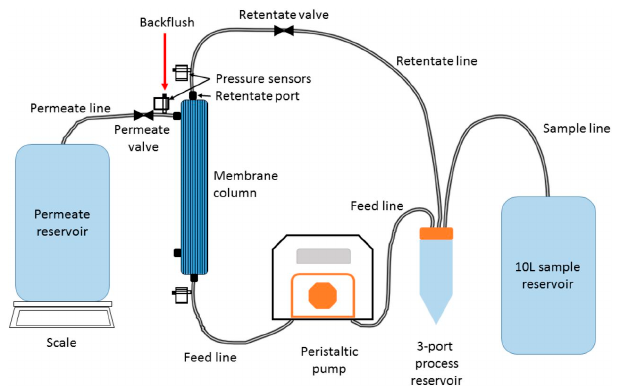
Figure 4. Schematic depiction of the experimental setup used for step one of the two-step preconcentration process for virus recovery from fresh and wastewater samples. (Re-printed from Farkas et al. [67]. Copyright (2018), with permission from MDPI